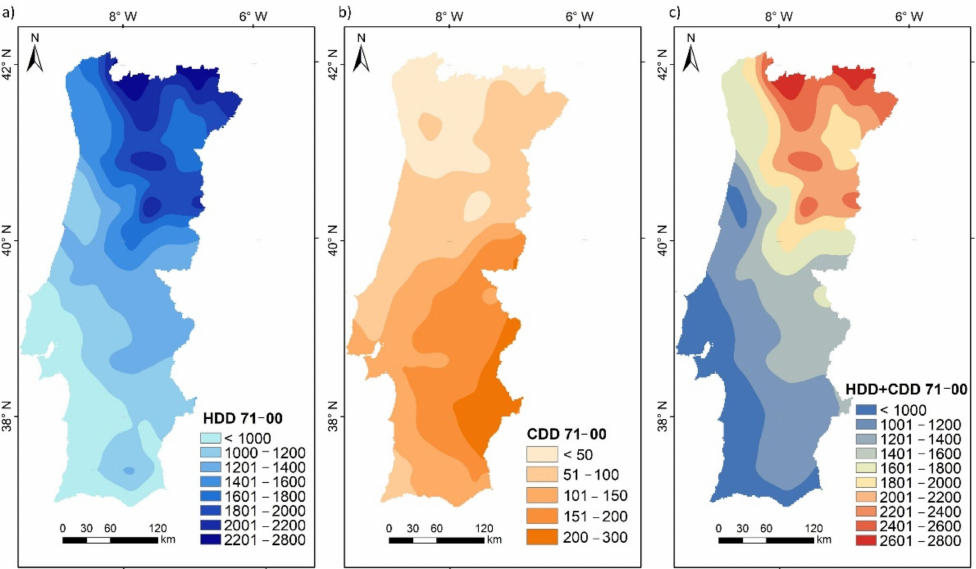
Figure 5. Mean values (in ◦ C × D per year) of ( a ) HDD, ( b ) CDD, and ( c ) HDD + CDD for the historical period (1971–2000) from E-OBS for Portugal (OK